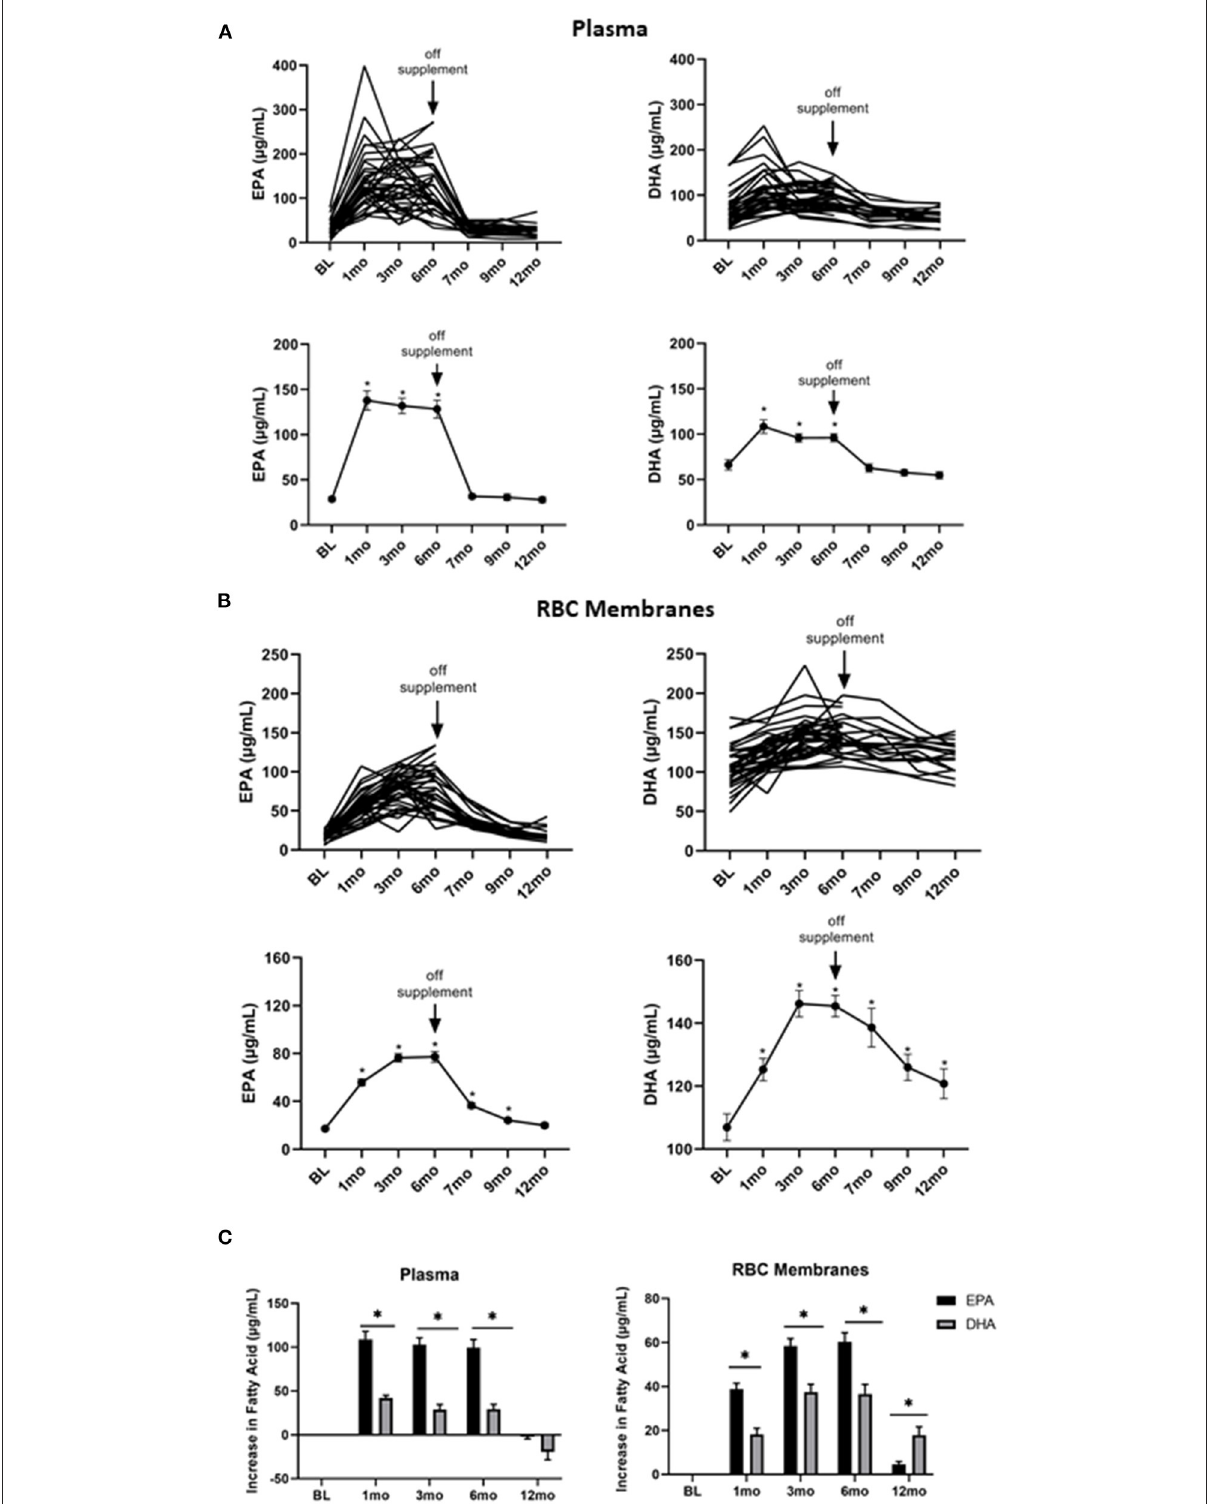
FIGURE2 Omega 3 supplementation significantly increases plasma and RBC membrane levels of EPA and DHA, as determined by GC-FID. (A) Upper panel: Individual plasma EPA and DHA levels over time from participants taking omega 3 supplements. BL = baseline values. Omega 3 supplements were taken for the first 6 months. Lower panel: Average plasma EPA and DHA levels over time from participants taking omega 3 supplements.